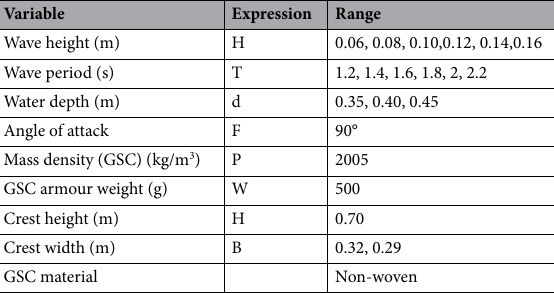
Table 1. Range of governing variables.